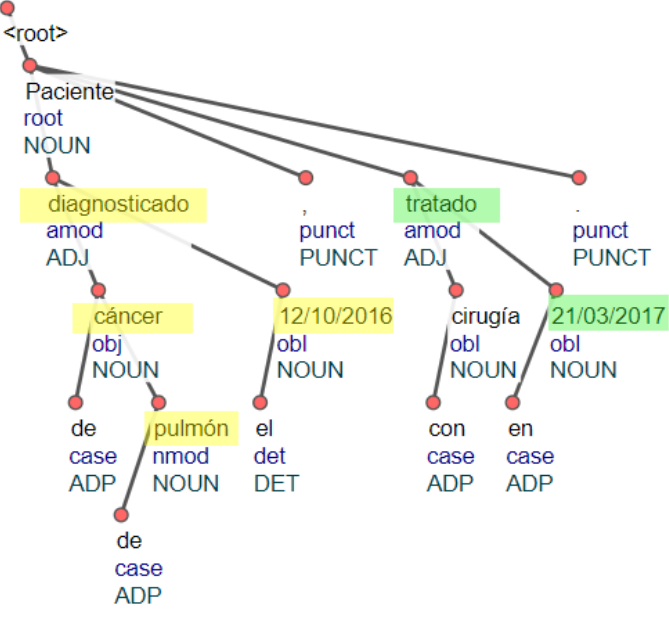
Figure 7. Parse tree: linking dates and cancer